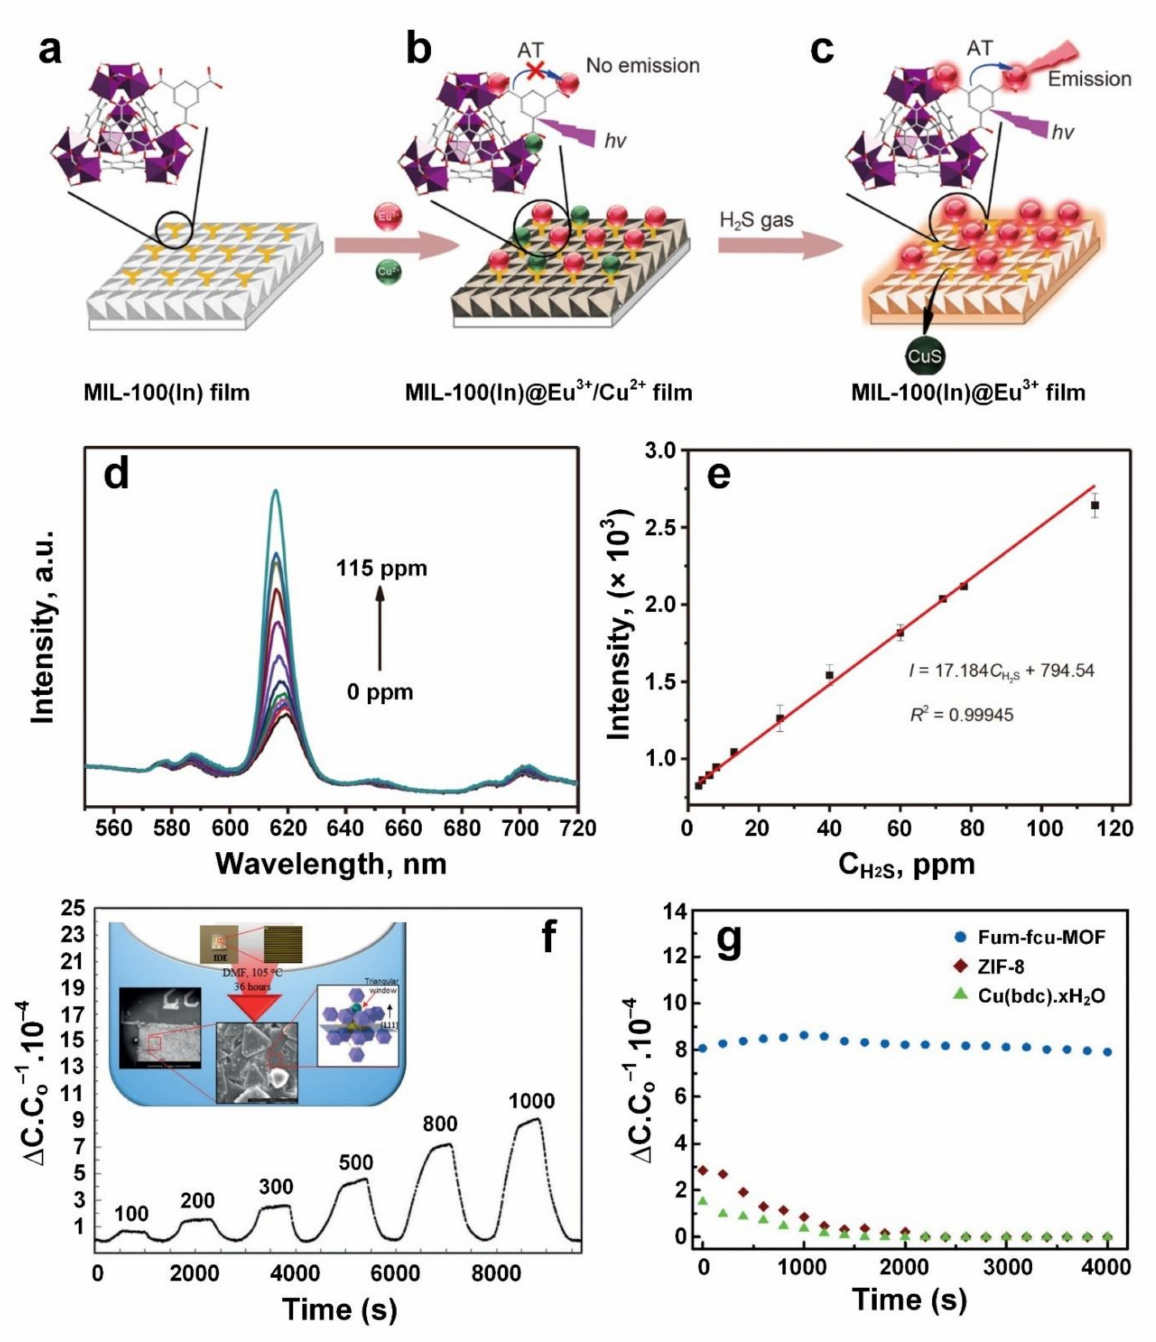
Figure 4. Schematic illustrations of MIL-100(In) based fluorescence sensor for H 2 S gas detection: The MIL-100(In) film coordinating BTC ligands on the surface ( a ) can be functionalized by Eu 3+ /Cu 2+ ions simultaneously with no emission of Eu 3+ ( b ); however, the characteristic emission of Eu 3+ in MIL-100(In)@Eu 3+ /Cu 2+ film could turn on with the presence of H 2 S gas ( c ). ( d , e ) Fluorescence intensity versus H 2 S gas at different concentrations at 40 ◦ C. Reproduced with permission from [92] Springer, 2019. ( f ) The dynamic response curves of fum − fcu − MOF against H 2 S gas at different concentrations, and the microstructure of fum − fcu − MOF coated on IDE (Inset). ( g ) The stability performance of fum-fcu-MOF against ZIF-8 and Cu(BDC) · xH 2 O MOF. Reproduced with permission from [93] Wiley-VCH,